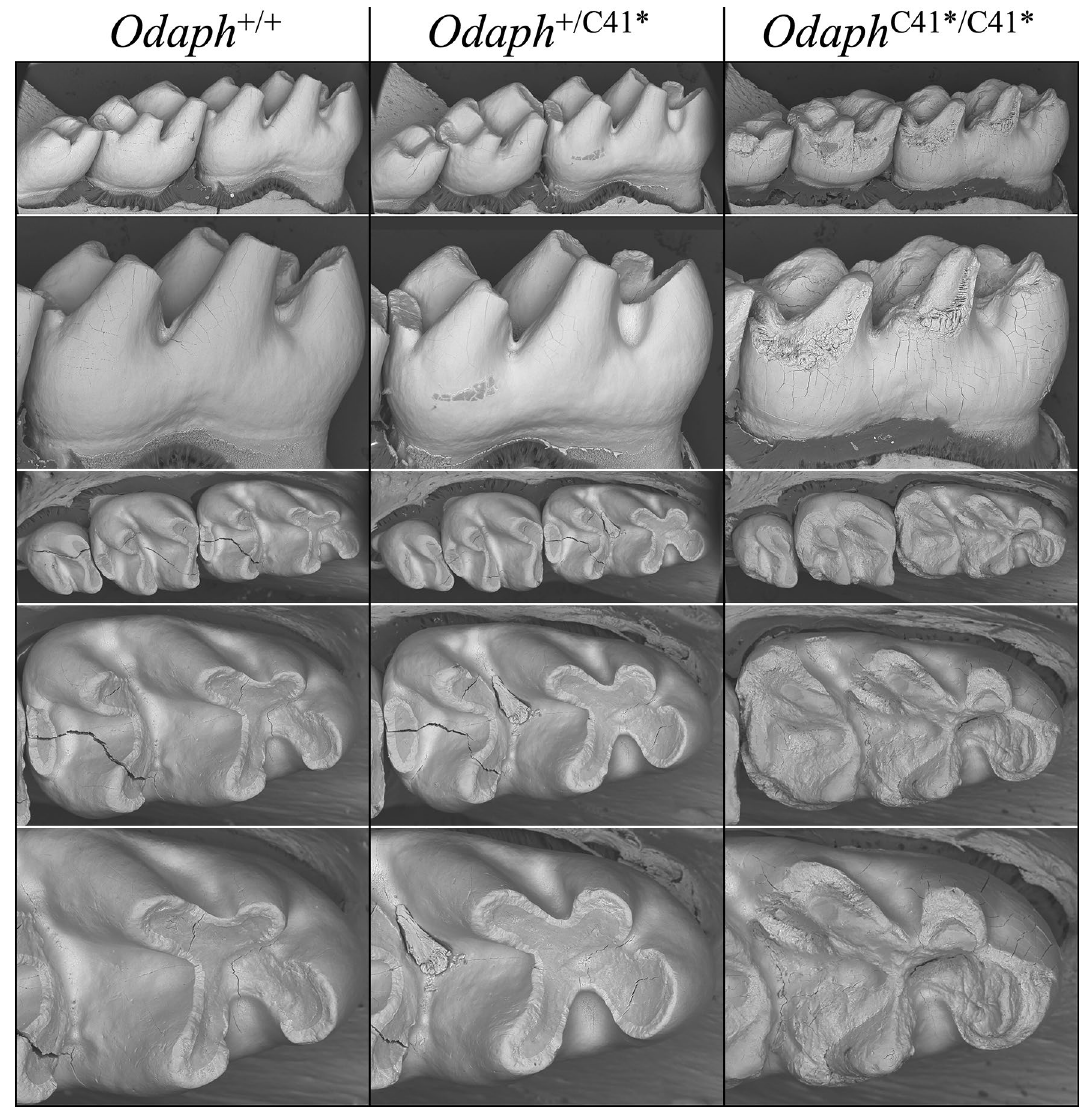
Figure 7. bSEMs of 7-wk Odaph +/+ , Odaph +/C41* , and Odaph C41*/C41* Mouse Mandibular First Molars. Lingual (top 2 rows) and occlusal (bottom 3 rows) views of 7-wk mandibular molars. No differences in attrition were observed between Odaph +/+ and Odaph +/C41* molars. The Odaph C41*/C41* molars showed extensive attrition. Like the incisors, the molar enamel seemed to reach full thickness but was soft and underwent attrition following